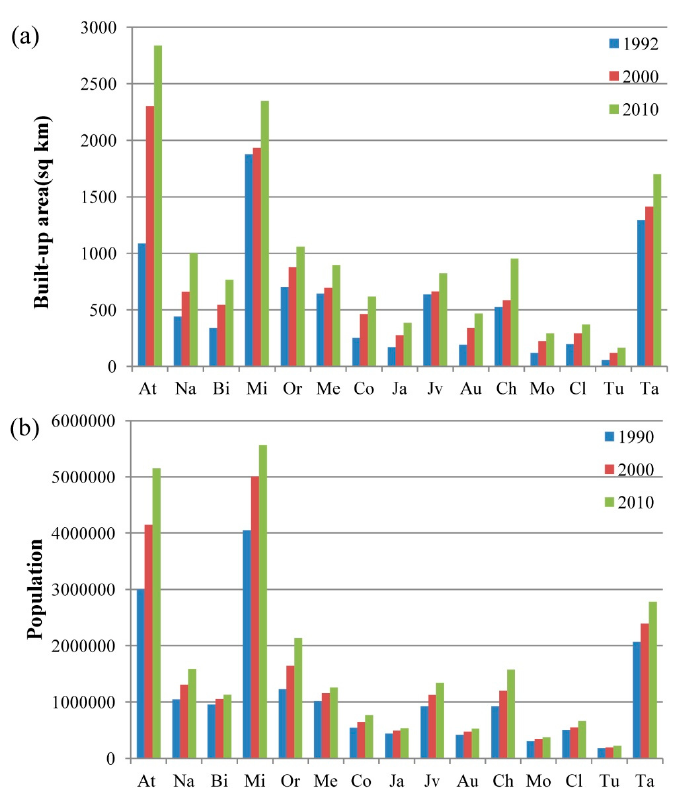
Figure 7. Changes of ( a ) built-up areas derived from VANUI data from 1992 to 2010 and ( b ) population from 1990 to 2010 in 15 metropolitan areas the Southeast U.S.A. Note: At = Atlanta-Sandy